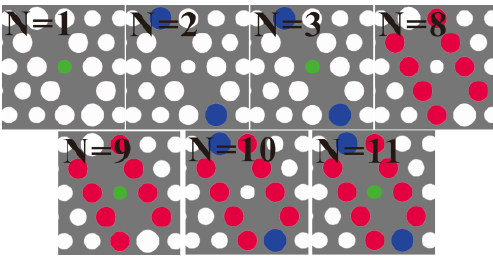
Figure 4. Various infiltration schemes for the structues with a shoulder-coupled cavity infiltrated with magnetic fluid (MF).